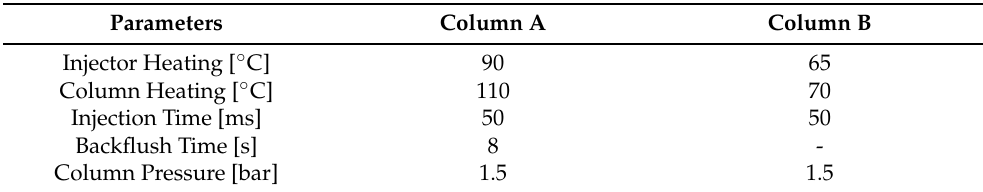
Table 4. Gas chromatography parameters for column A and B, analyzing the conductivity of lighter and heavier